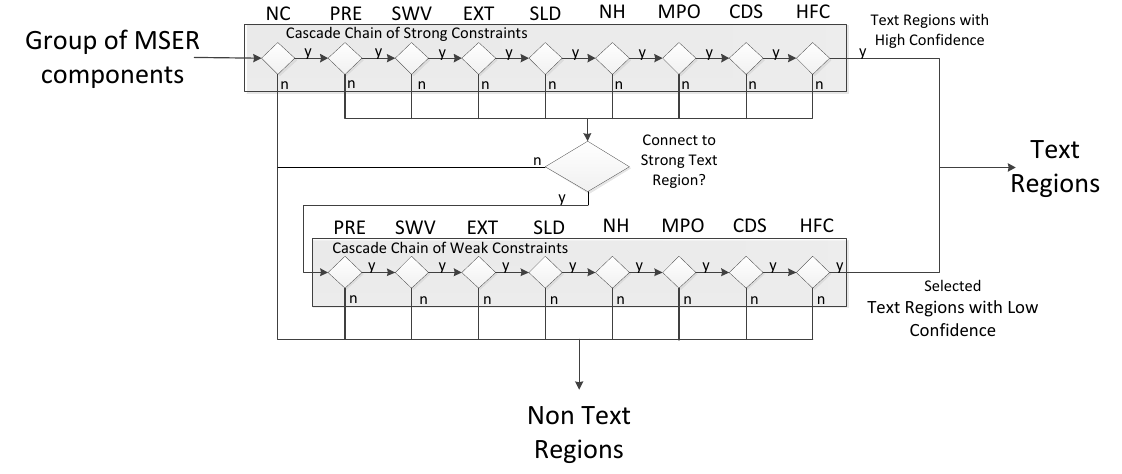
Figure 8. The propsoed double-thresold scheme for text and non-text